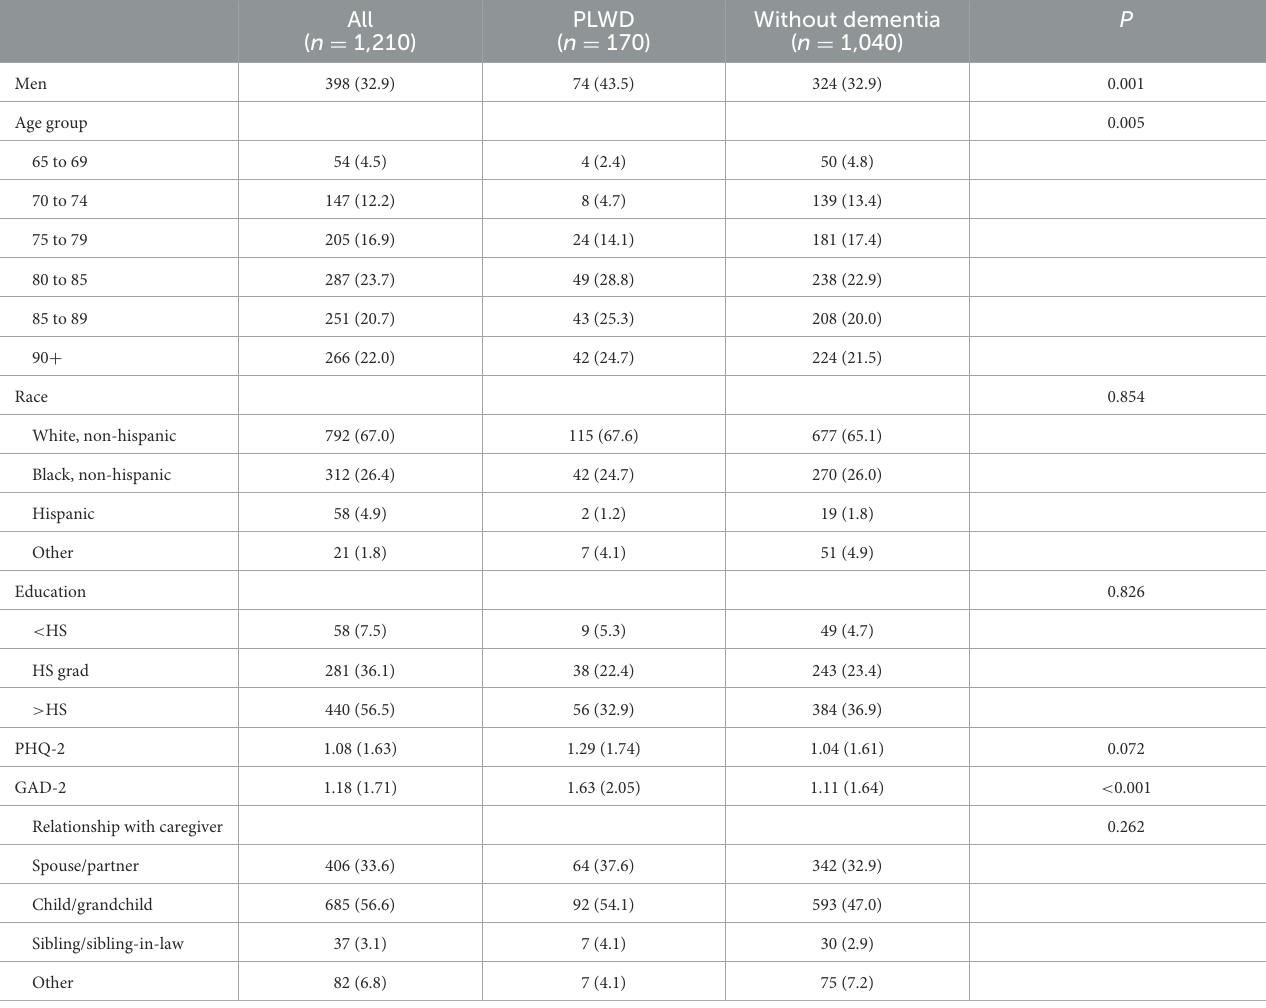
TABLE 2 Care recipient characteristics comparing those with and without dementia, N (%) or mean (SD) for PHQ-2 and GAD-2.